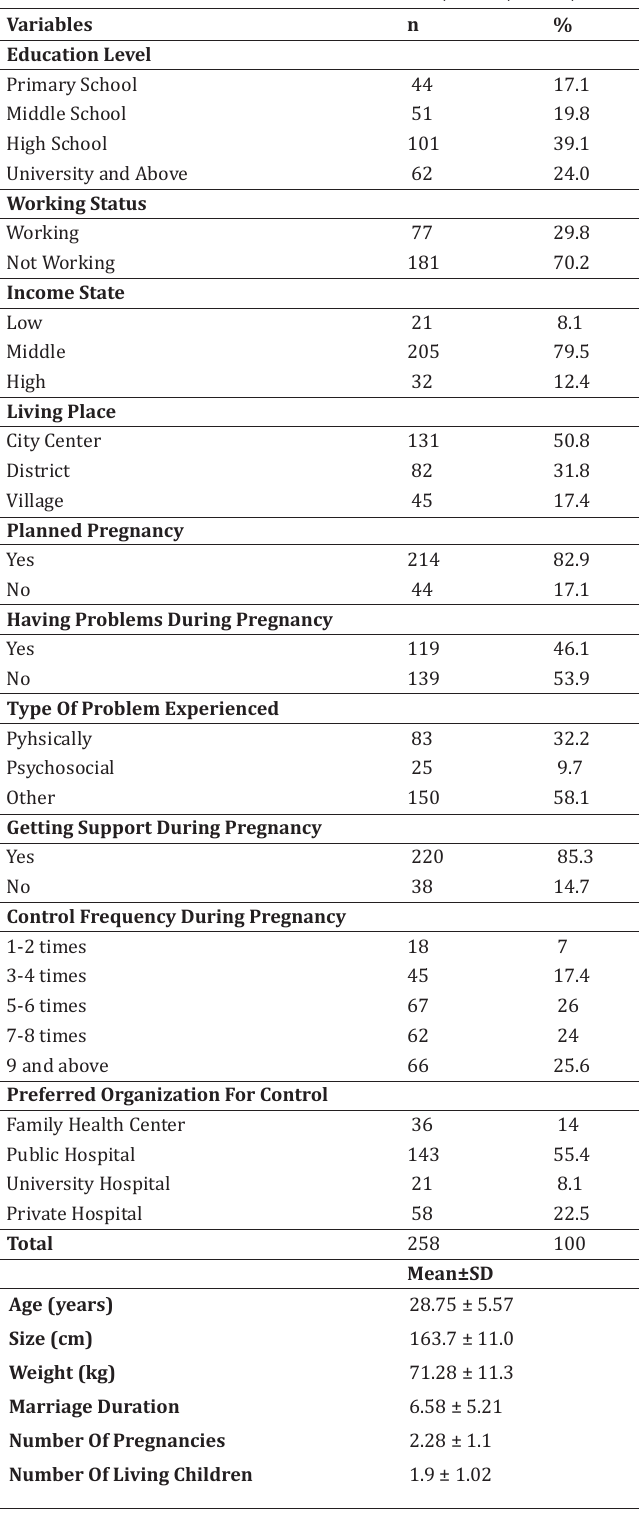
Socio-demographic and Obstetric Characteristics of the Participants